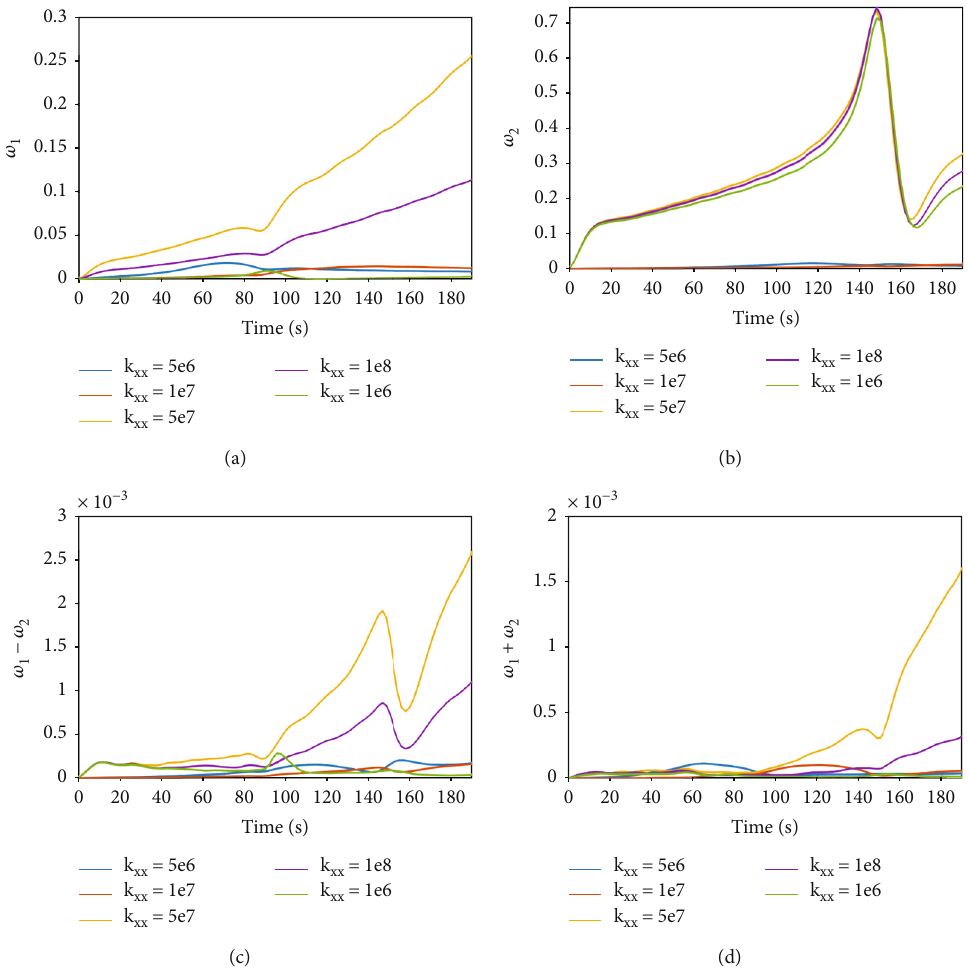
ω ω − ω ω + ω 1 ; (b) 2 ; (c) 1 2 ; (d) 1 2